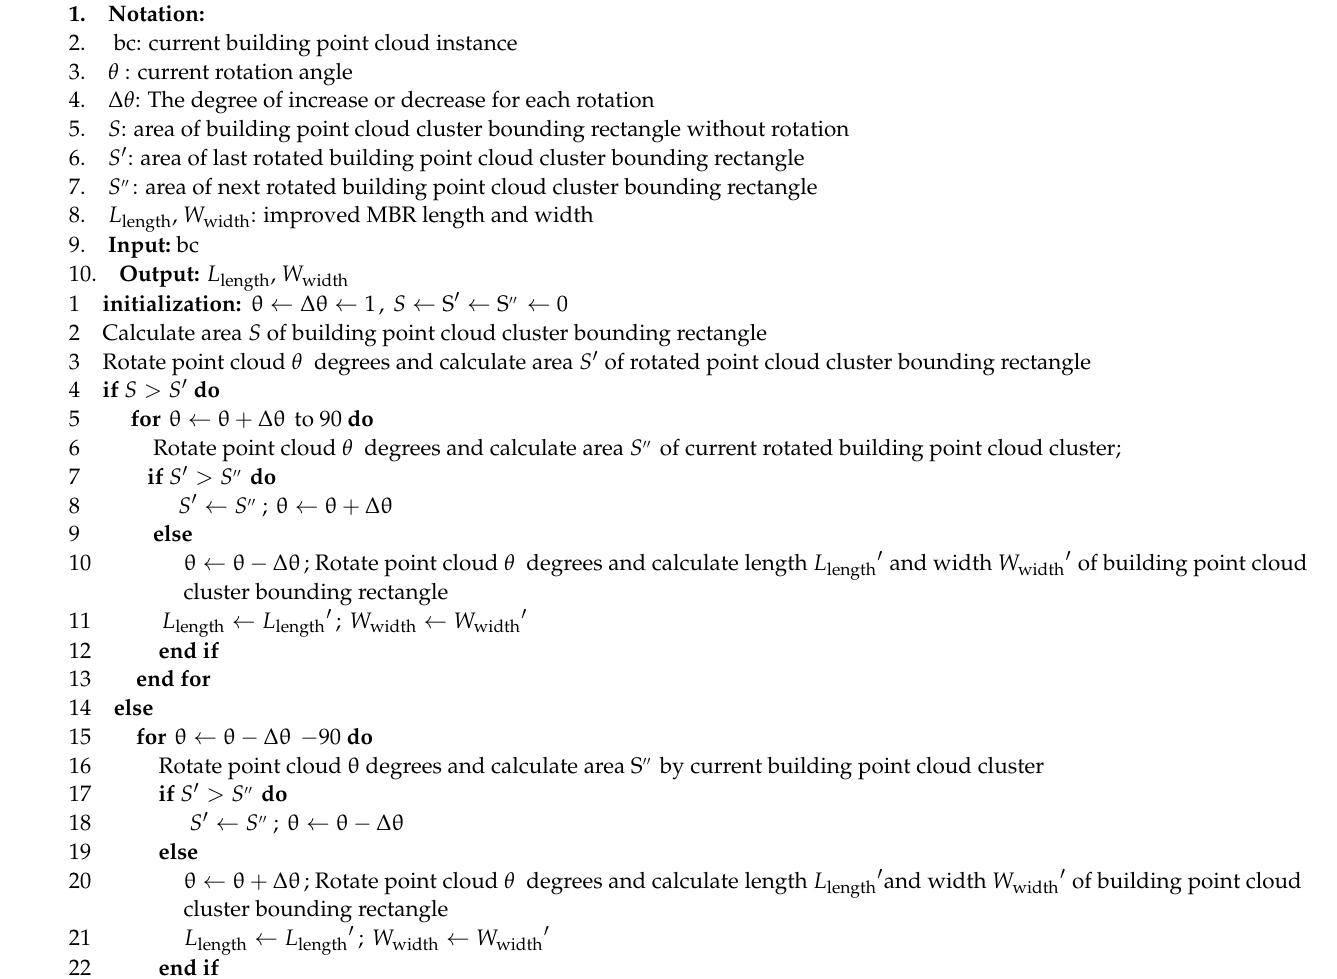
Algorithm 1. The improved minimum bounding rectangle (MBR)